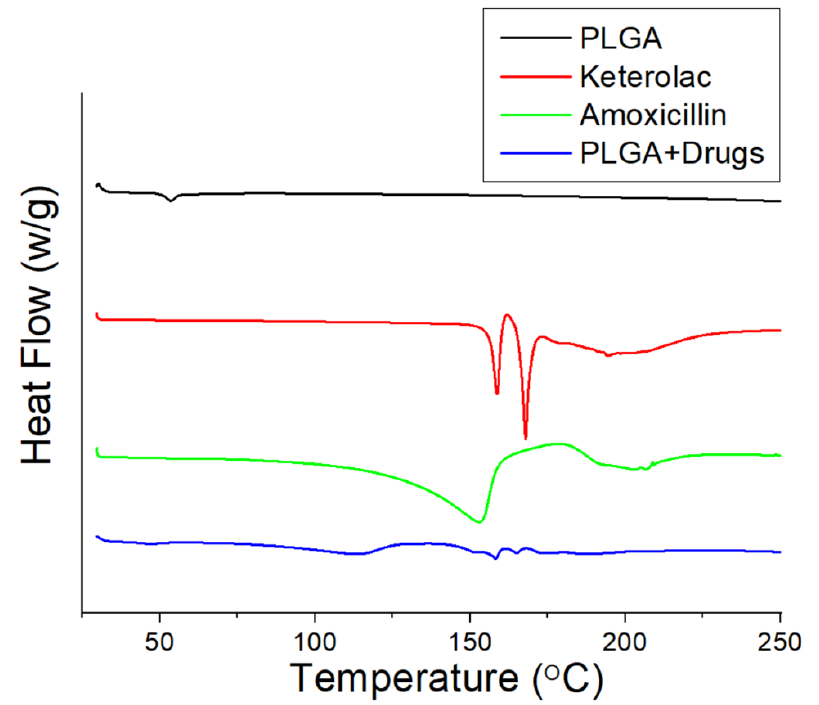
Figure 6. Differential calorimetry scanning (DSC) thermograms of virgin PLGA, ketorolac, amoxicillin, and ketorolac-amoxicillin-incorporated PLGA nanofibers.